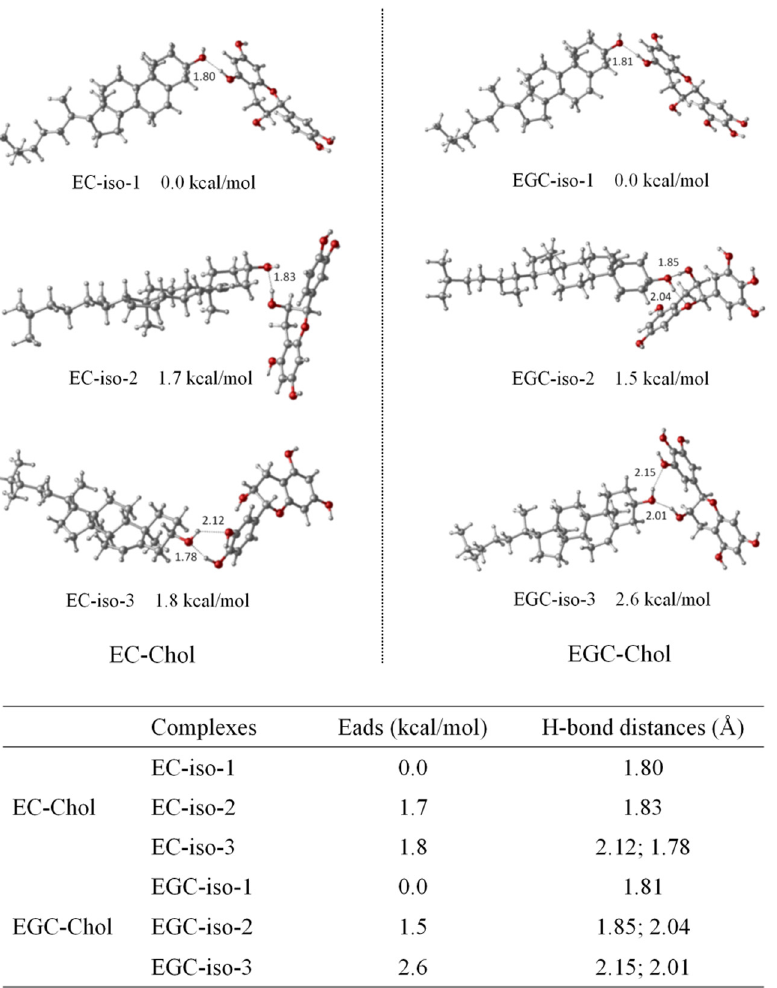
Figure 2: Molecular structures, E ads and H - bond distances of EC – cholesterol ( EC – Chol ) and EGC – cholesterol ( EGC – Chol )